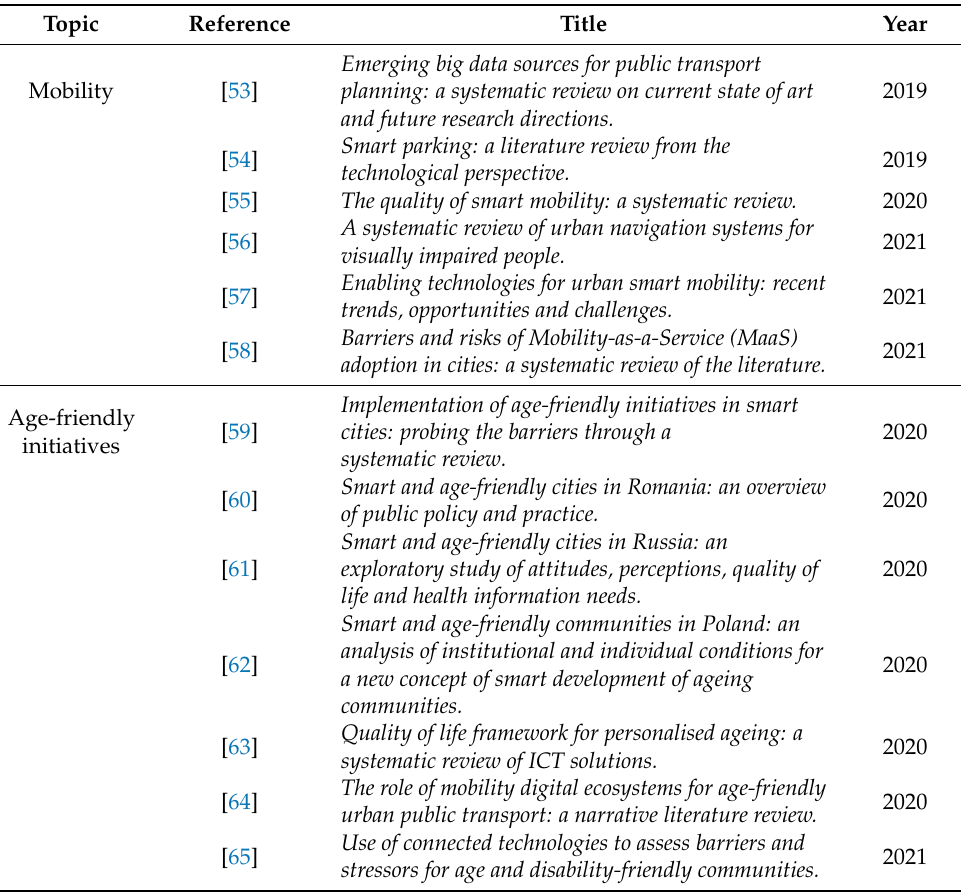
Table 1. State-of-the-art reviews related to smart city mobility and age-friendly